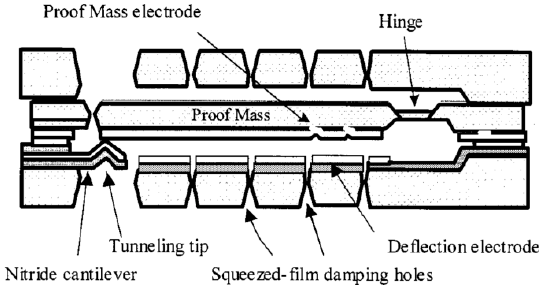
Figure 20. Schematic diagram of a MEMS tunneling accelerometer developed by Liu and Kenny at Stanford University [118].